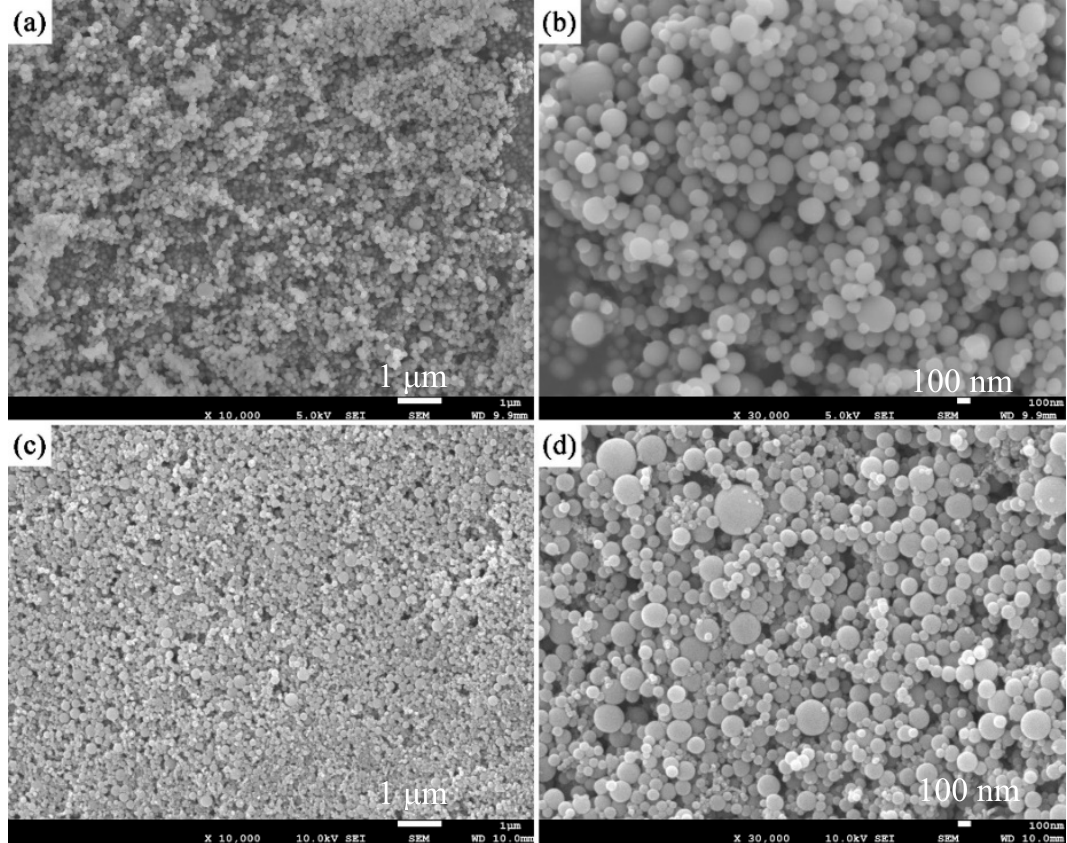
Figure 10. FESEM images of the large-scale produced nanopowders: ( a , b ) Si, ( c , d ) Al 2 O 3 .